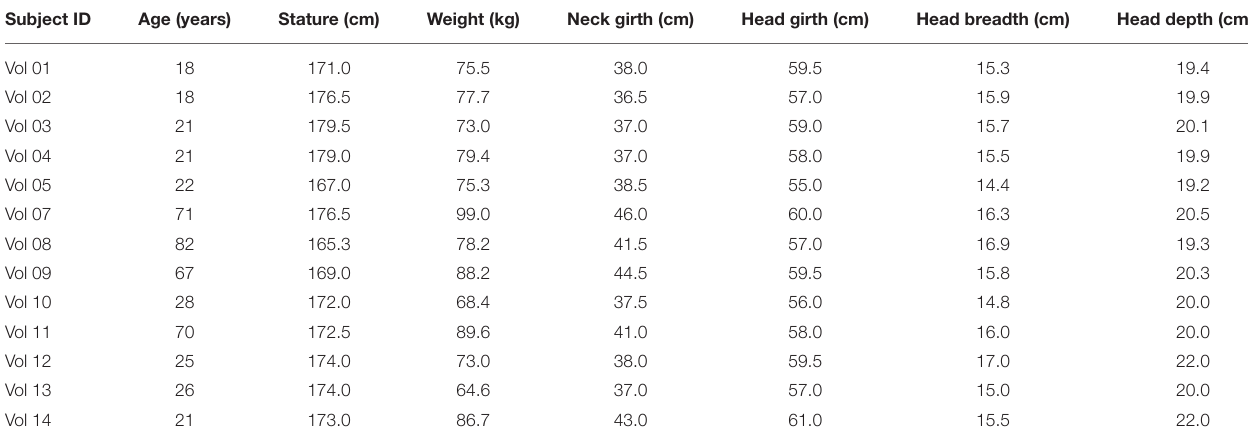
TABLE 1 | Anthropometry and main characteristics of volunteers.